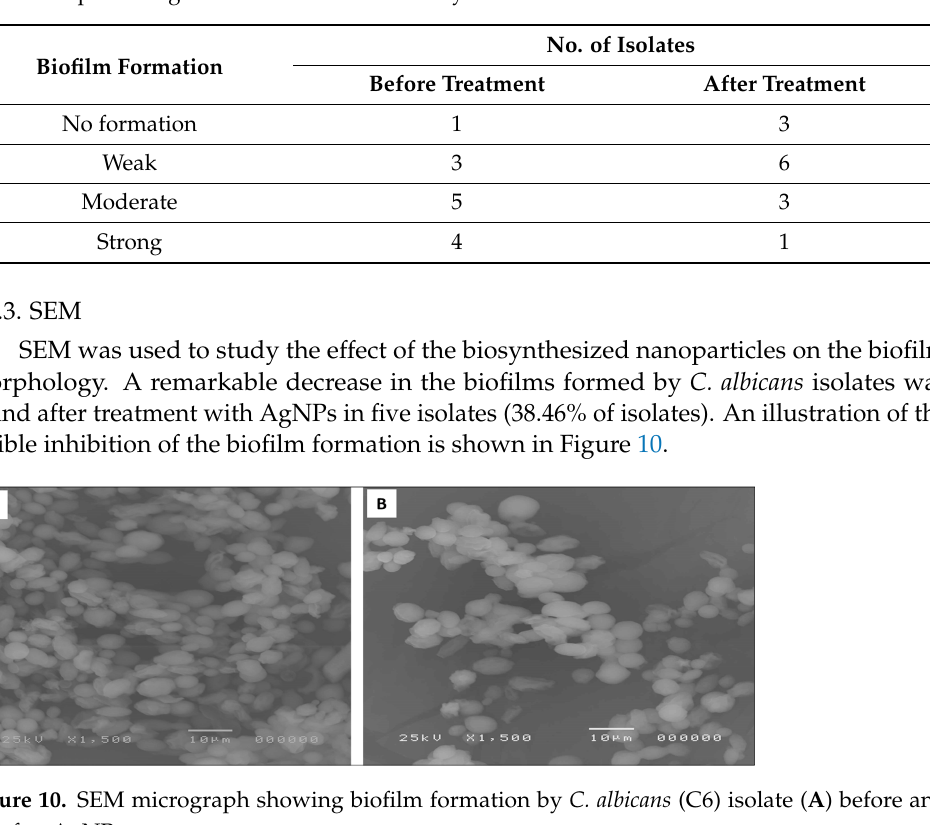
Table 2. Impact of AgNPs on biofilm formation by C. albicans isolates.